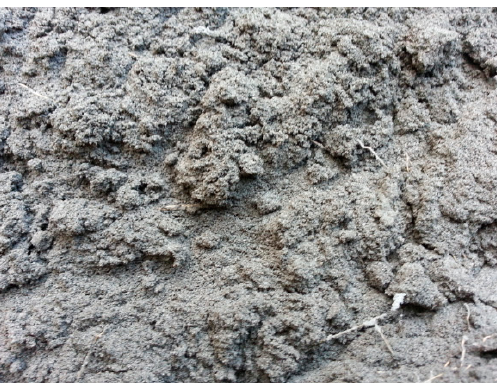
Figure 22. Foam concrete generated by NaDDBS.